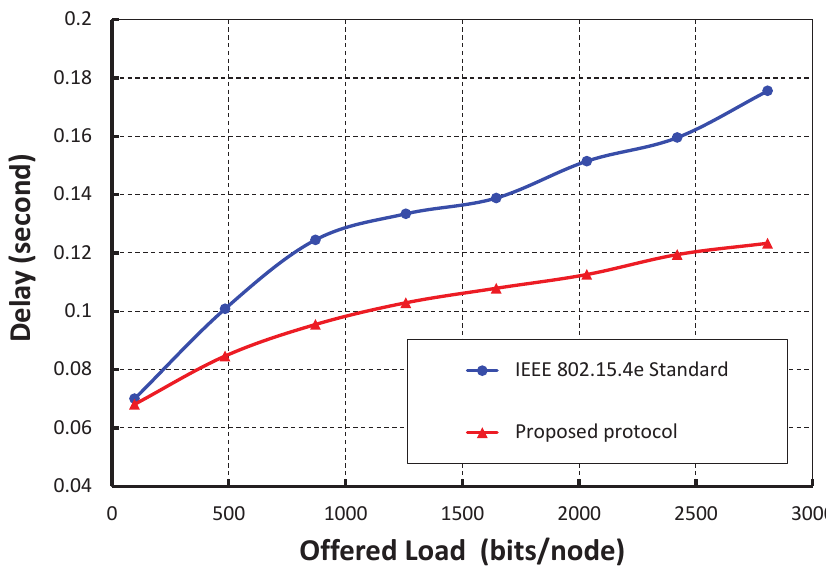
Figure 13. Comparison of the transmission delay of our protocol with the IEEE 802.15.4e standard.